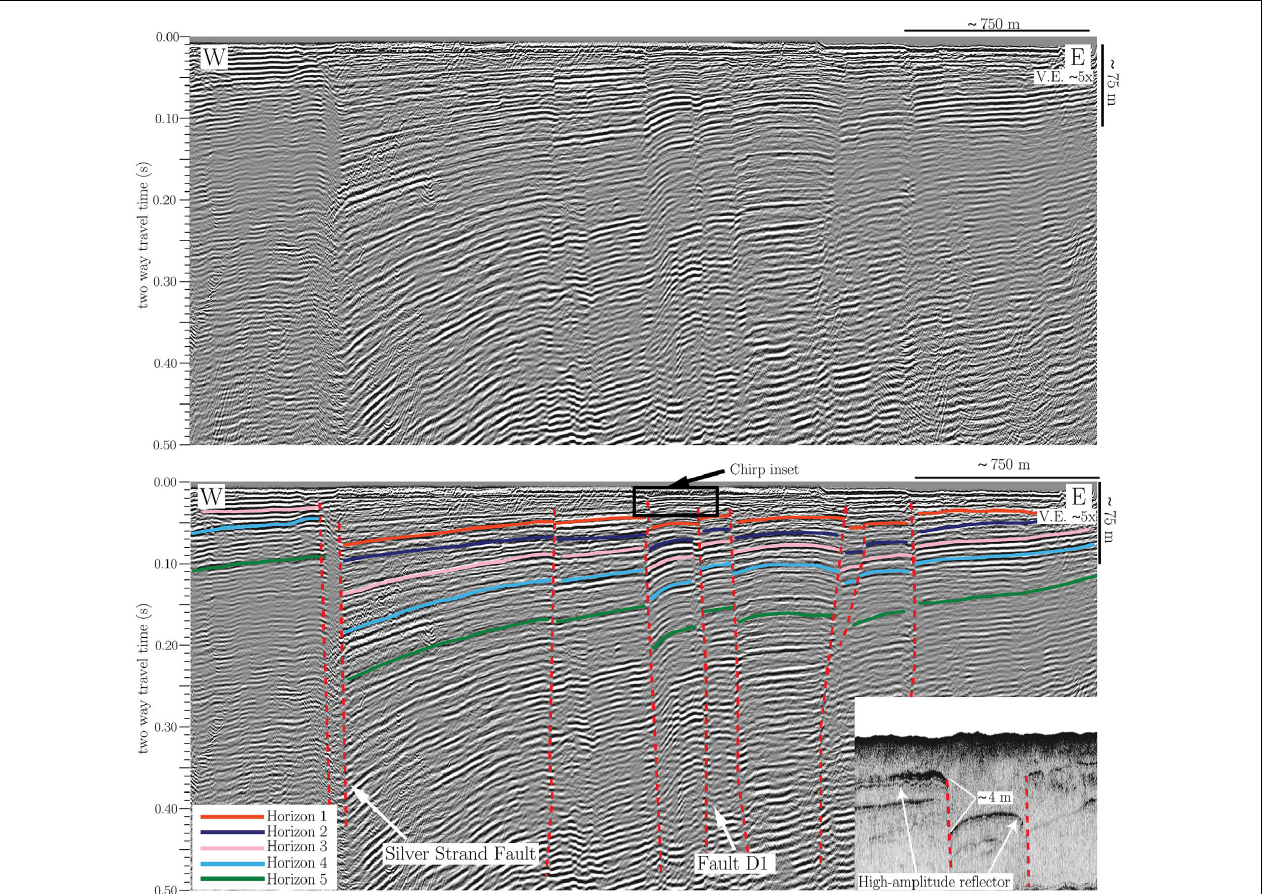
FIGURE 3 | Multi-channel seismic (MCS) profile T196-098 showing large displacement across the Silver Strand fault and westward dip of stratigraphy into both the Silver Strand fault and Fault D1. West of the Silver Strand fault, stratigraphy is flat lying to gently west dipping. Large apparent offset across the Silver Strand fault and uniform character of reflectors west of the fault make stratigraphic correlations difficult and increase uncertainty in interpretations across the fault. Inset shows offset high amplitude irregular reflector interpreted to represent the MIS stage 5e Nestor Terrace. Shown in the bottom panel are the five horizons used to observe changes in stratigraphy across San Diego Bay. Profile location shown in Figure 2